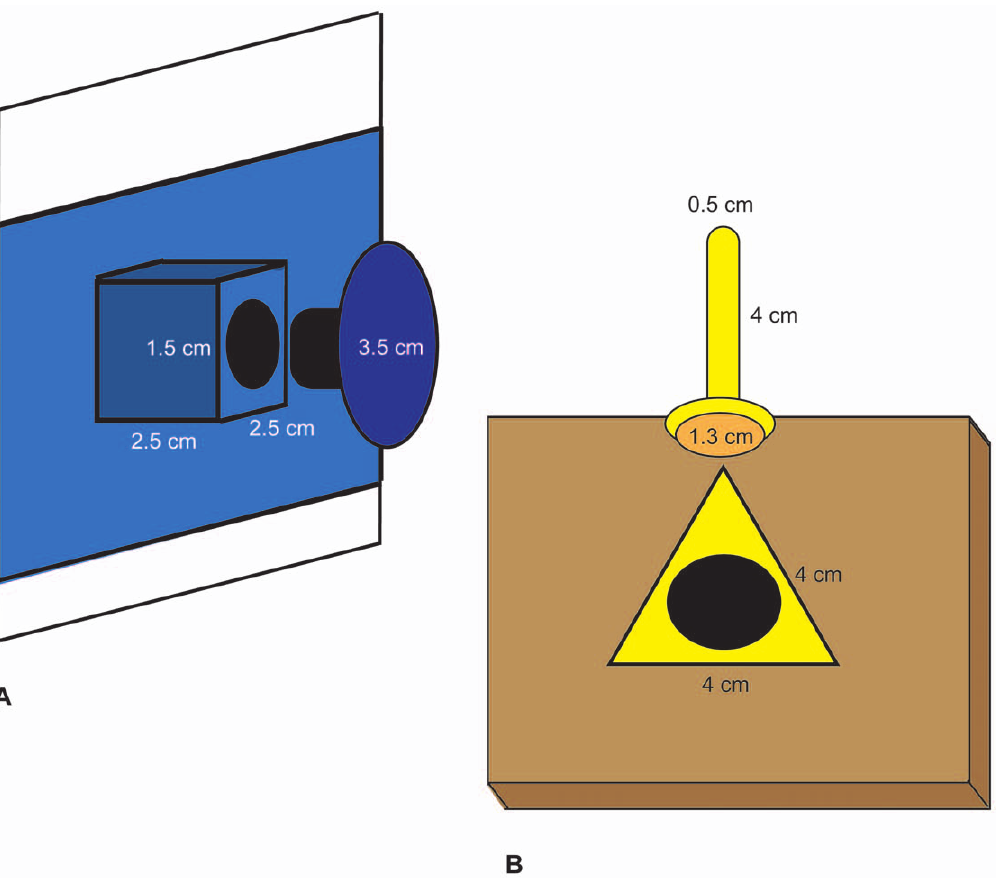
Figure 1. The base of the apparatus for the lid task (A) consisted of a wooden grid (26 6 22 6 2 cm) surrounded by corrugated-plastic walls (28 cm high) on three sides. Ten wooden cubes wrapped in blue tape were attached to the walls 4.5 cm from the cage floor at 4.5 cm intervals. Each cube contained one well (0.8 cm deep, 1.5 cm wide) with 2 white millet seeds, covered with a blue circular cardboard lid. The cardboard lid was lined with blue tape and pierced with a 1 cm-long screw. The screw was wrapped in foam material so that it fitted snugly into the well. To solve the task, the bird had to grab the edge of the cardboard lid with its beak and flip it out of the well. The base of the apparatus for the stalk task (B) consisted of a wooden grid (26 6 22 6 2 cm) with two rows of 5 wells (0.8 cm deep, 1.5 cm wide) spaced 4.5 cm apart. Each well opening was at the centre of a triangle of yellow tape. Each well contained 2 white millet seeds and was covered with a wooden stalk wrapped in yellow tape, to which a vinyl bumper was attached at the bottom with a pushpin. To extract the seed, the bird had to grab the stalk with its beak and pull it out of the well.